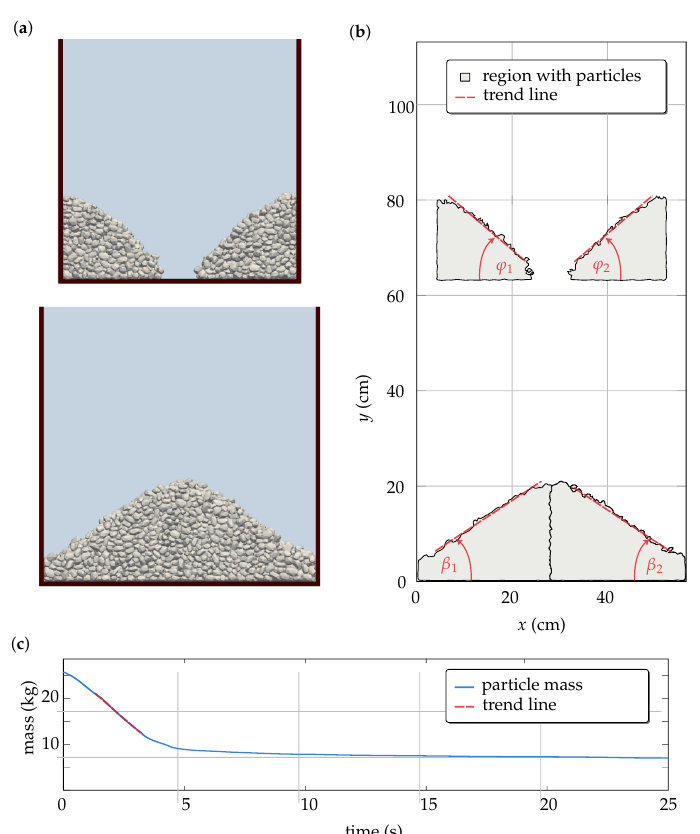
Figure 6. DDT DEM simulation post-processing of quartz with 4 polyhedral particles: ( a ) front view of DEM simulation, ( b ) border of particles and calculated angles, ( c ) evolution of the total particle mass in top